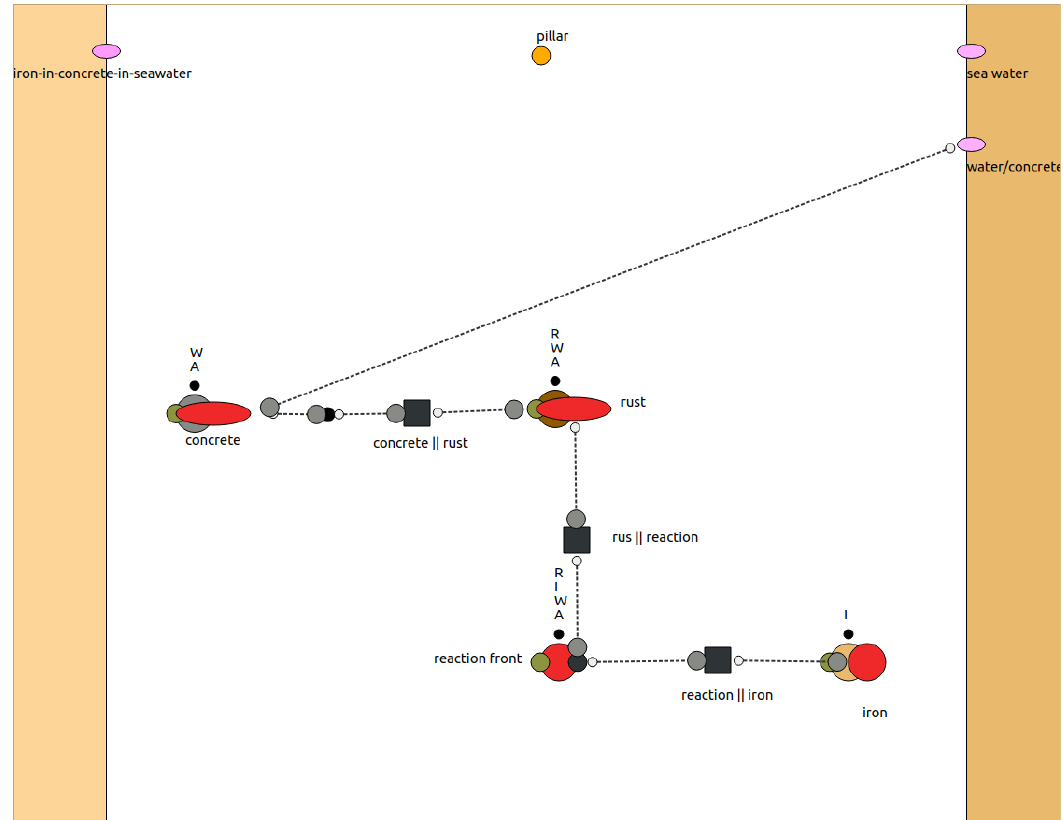
Figure 14. Rusting iron in concrete, a view of the ProMo’s graphical modeller showing the pillar model. The concrete and rust are modelled as distributed systems (ellipses). The reaction front is modelled as an infinitely small lumped system (black dot), decorated with the large red dot indicating the reaction front and the green dot indicating the solid. The iron is modelled as a lumped system. “R”, “I” stand for the species rust and iron. The left strip elements show the parents, while the ones on the right are the siblings in the